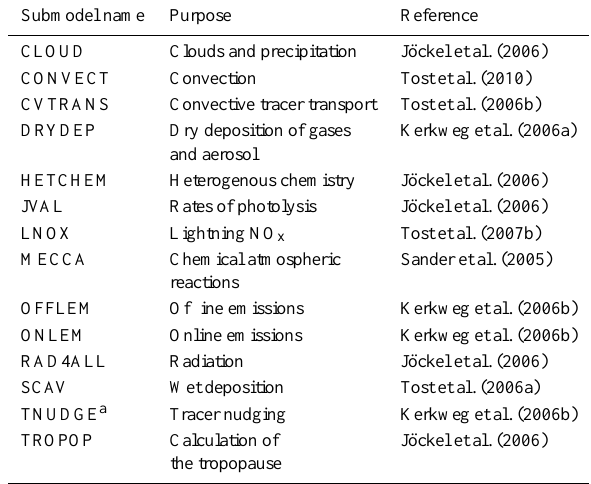
Table 1. Summary of the EMAC submodels used in this study. HETCHEM is used to calculate stratospheric reaction rates (and the rate of conversion of N 2 0 5 in the troposphere). TNUDGE nudges concentrations of long lived species (e.g. CH 4 and N 2 O) at the sur-